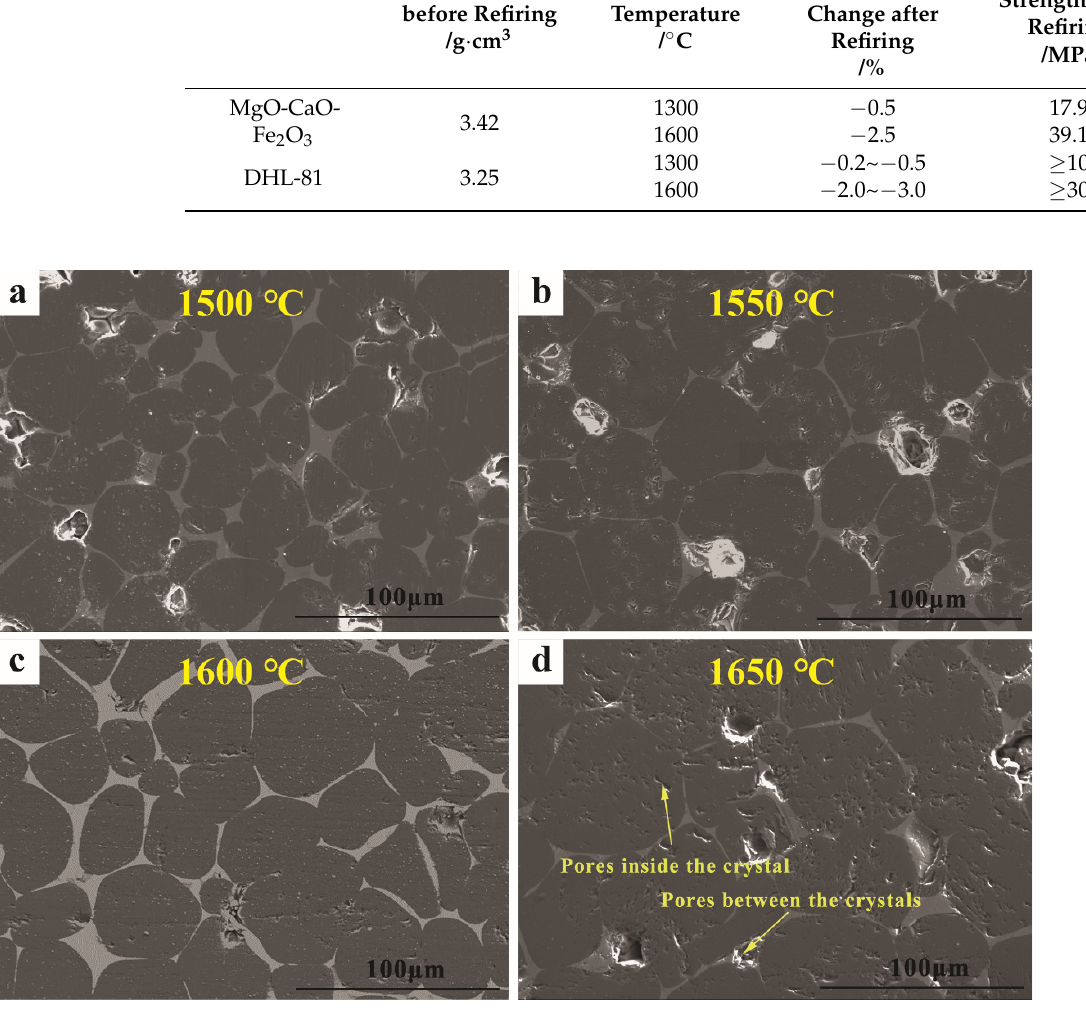
Figure 5. Microstructure of MgO ‐ CaO ‐ Fe 2 O 3 clinker fired at different temperatures. ( a ) 1500 °C ( b